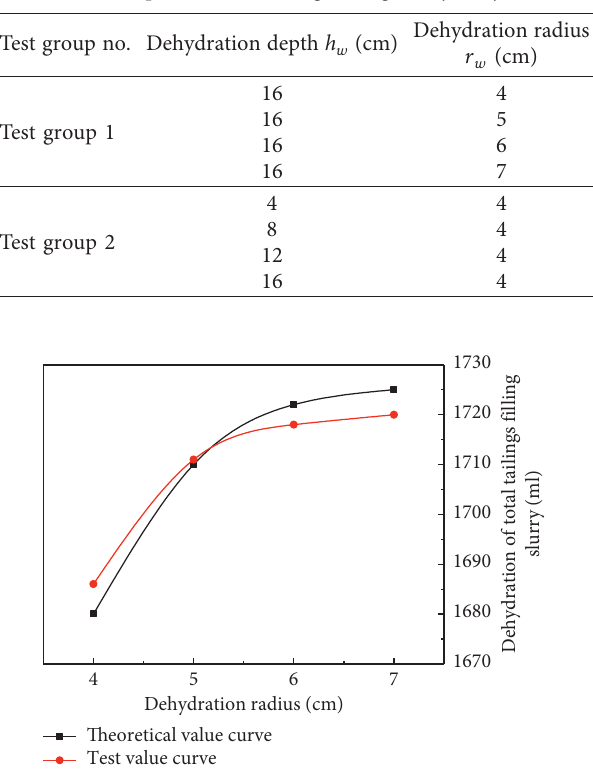
Dehydration depth (cm) Figure 4: Variation of dehydration amount with dehydration depth. Figure 3: Variation of dehydration amount with dehydration Table 2: Test plan of total tailings filling slurry dehydration.